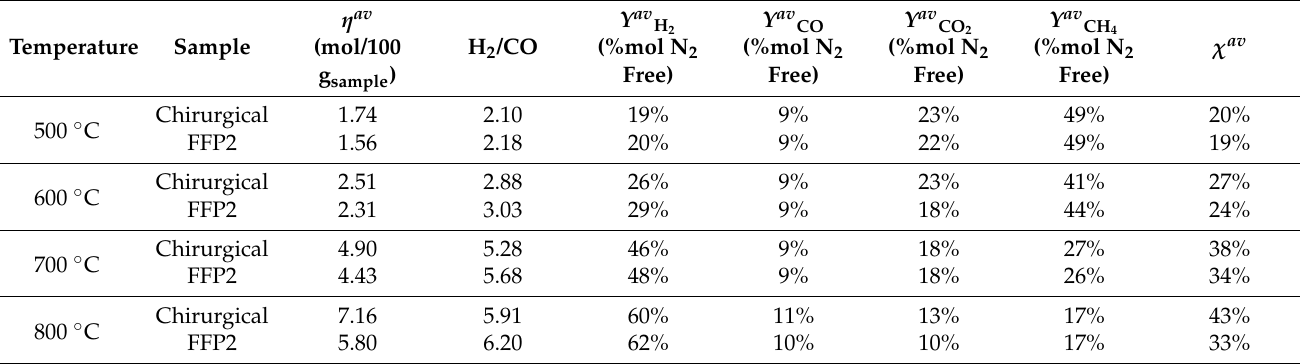
Table A2. Average values of pyrolysis parameters in N 2 and air atmosphere for dry samples.